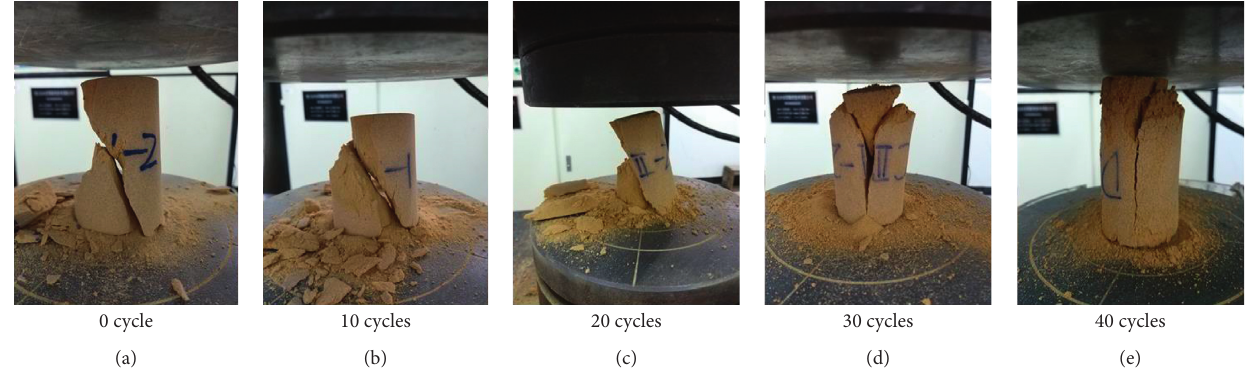
Figure 16: Failure pattern of the sandstone that suffered different F-T cycles in the uniaxial compression